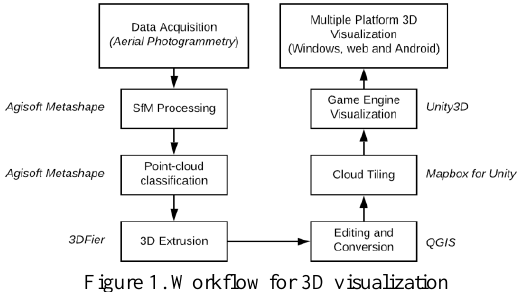
Figure 1. Workflow for 3D visualization